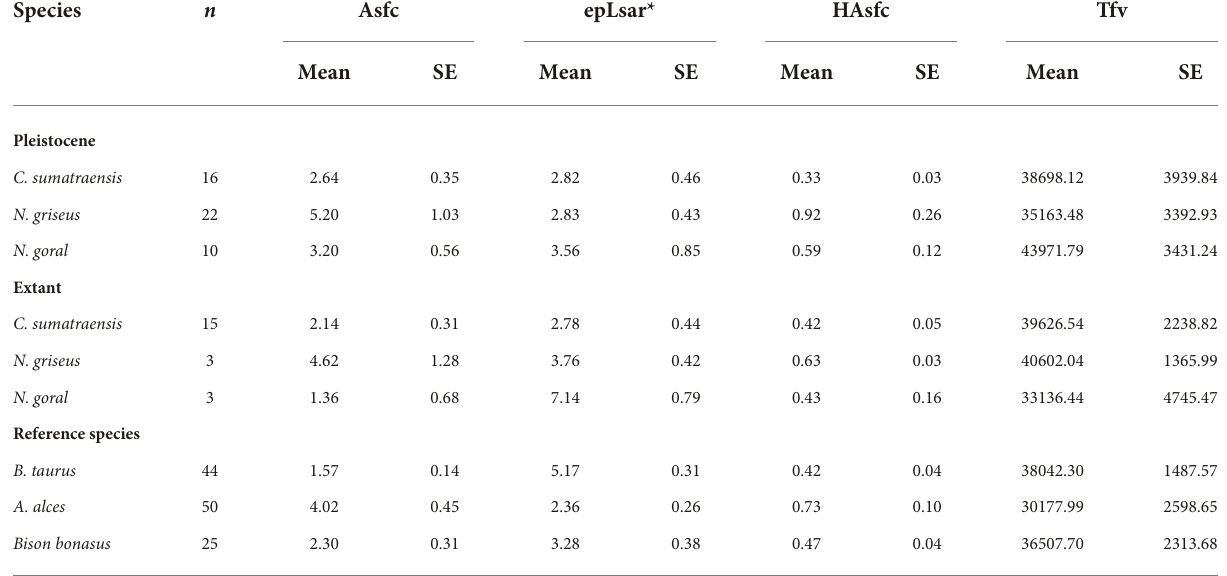
TABLE 4 Descriptive statistics (mean and standard error, SE) of microwear textural parameters for Pleistocene and extant caprines and reference species. Species n Asfc epLsar* HAsfc Tfv Mean SE Mean